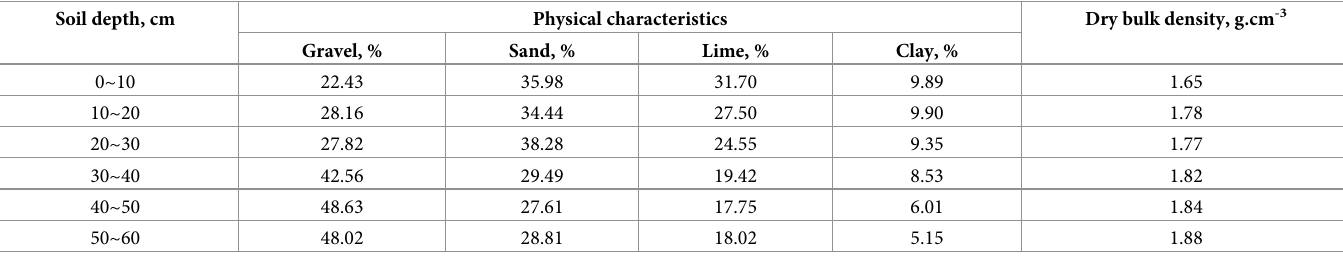
Table 1. Soil physical properties the experimental zone. Soil depth,